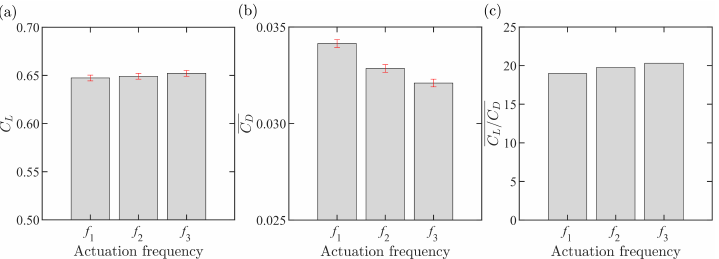
Figure 9. Time averaged ( a ) C L , ( b ) C D and ( c ) C L / C D of at f 1 , f 2 and f 3 , which correspond to low, intermediate, and fast membrane actuation frequencies, respectively. Error bars for C L and C D are included in the